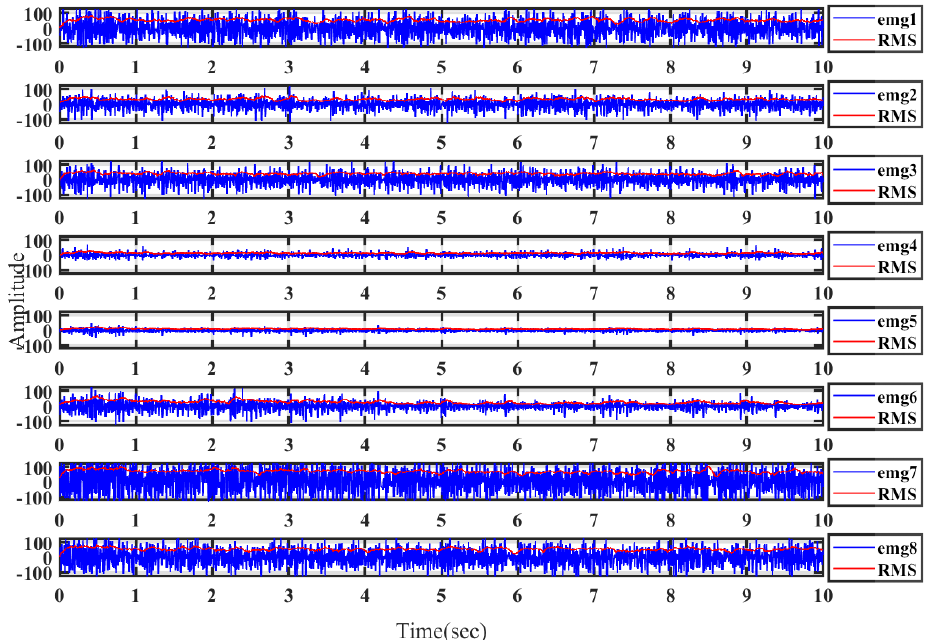
Figure 22. Gesture 1 (fist) maintained for 10 s. The EMG signal and RMS graph of the eight sensors in the sEMG bracelet.